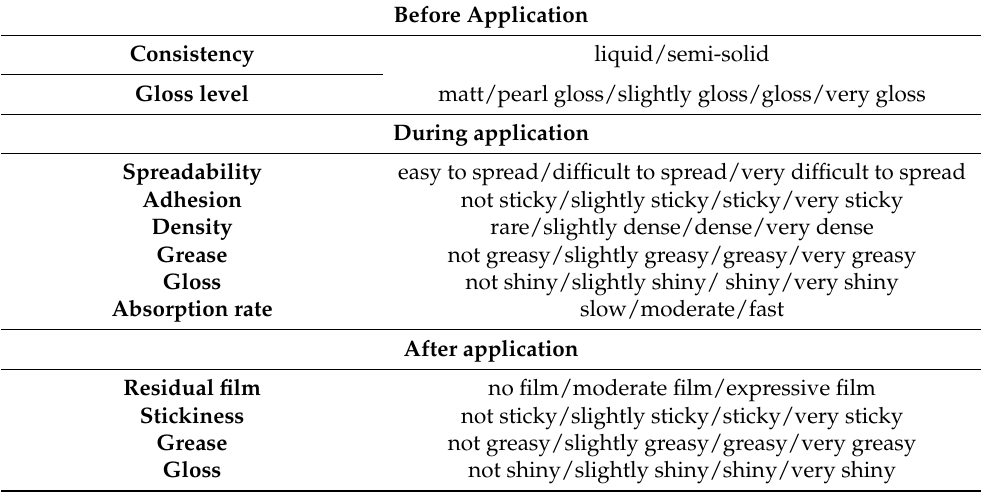
Table 2. Sensory evaluation